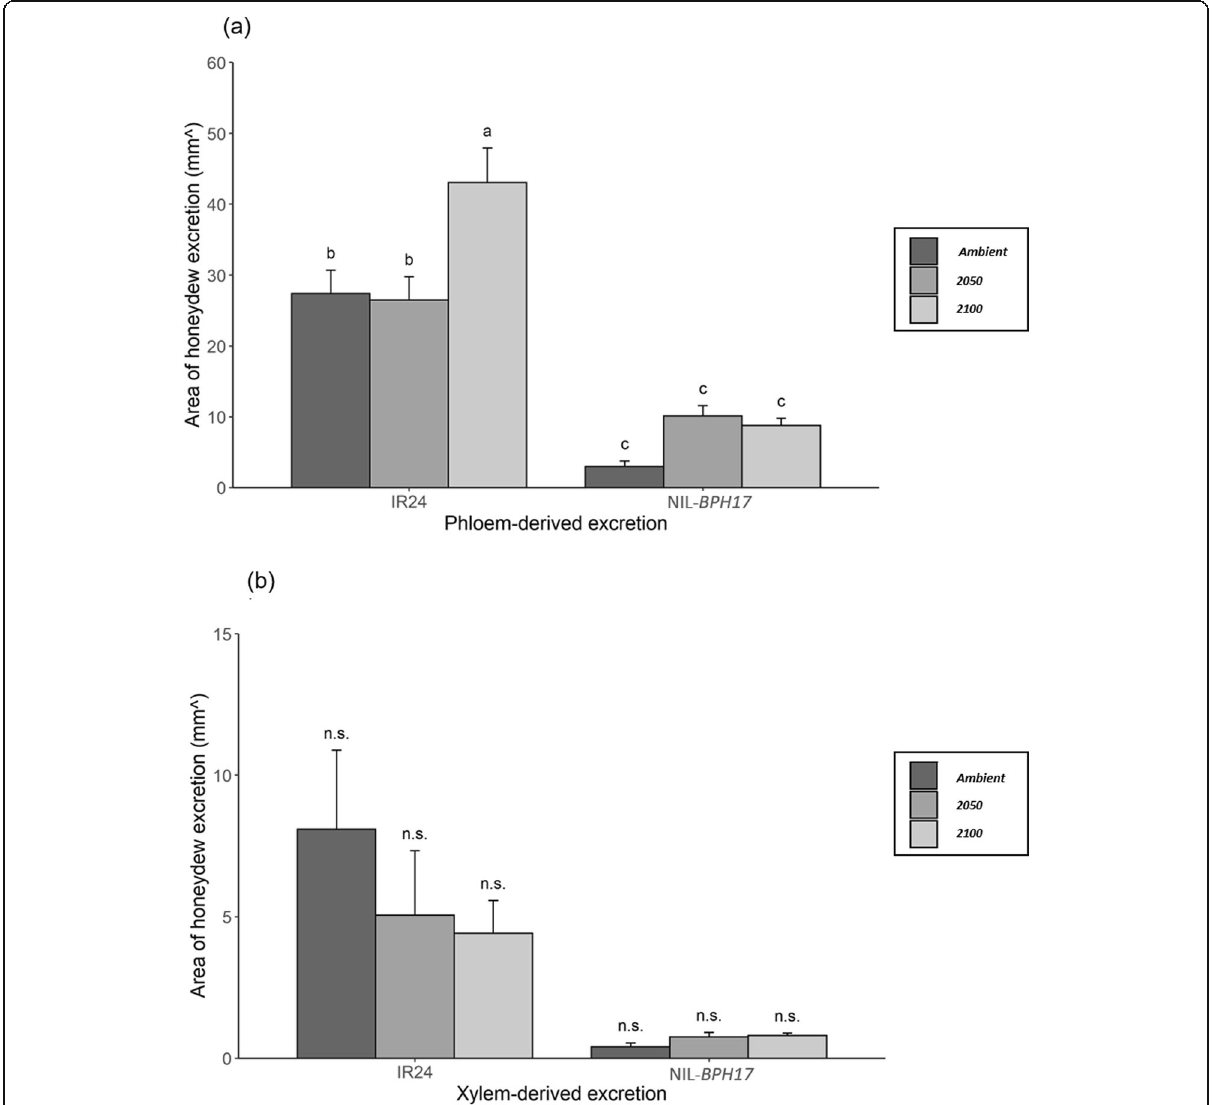
Fig. 1 Areas of honeydew excretion of N. lugens female feeding on IR24 and NIL- BPH17 under different environments. a